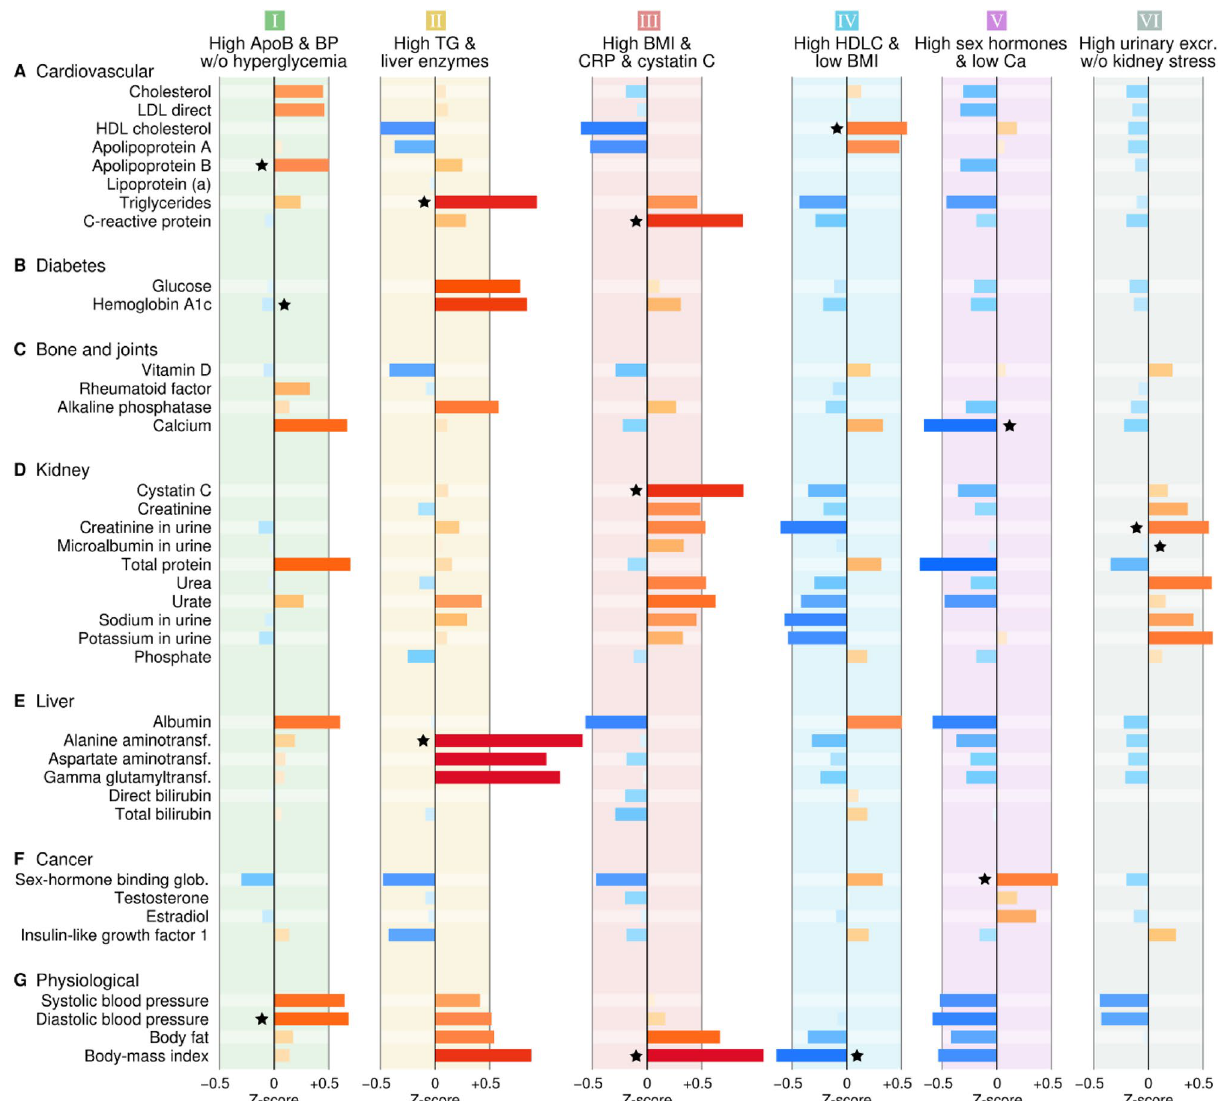
Figure 4. Mean metabolic profiles for SOM subgroups normalized by population SD. The bars are colored according to the direction and magnitude of the deviation from the population mean. The black stars indicate characteristic features that were selected for simplified naming of the